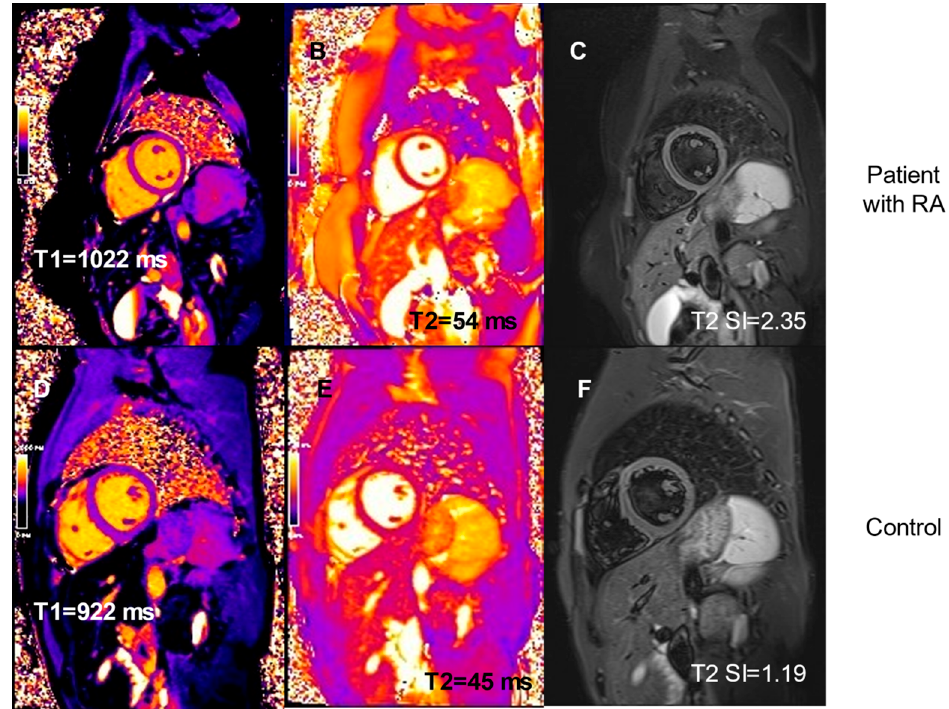
Figure 2. Examples of cardiac magnetic resonance images in mid-ventricular short axis views demonstrating signs of myocardial oedema in patients with RA and lack of those in controls: T1 pre-contrast time ( A , D ), T2 time ( B , E ), and T2 SI ratio ( C , F ).